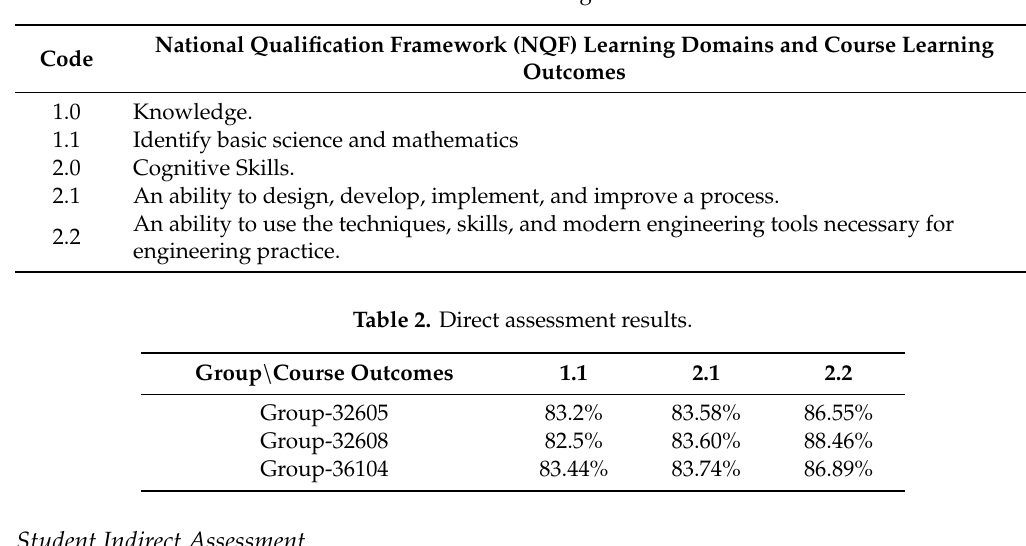
Table 1. Course learning outcomes.